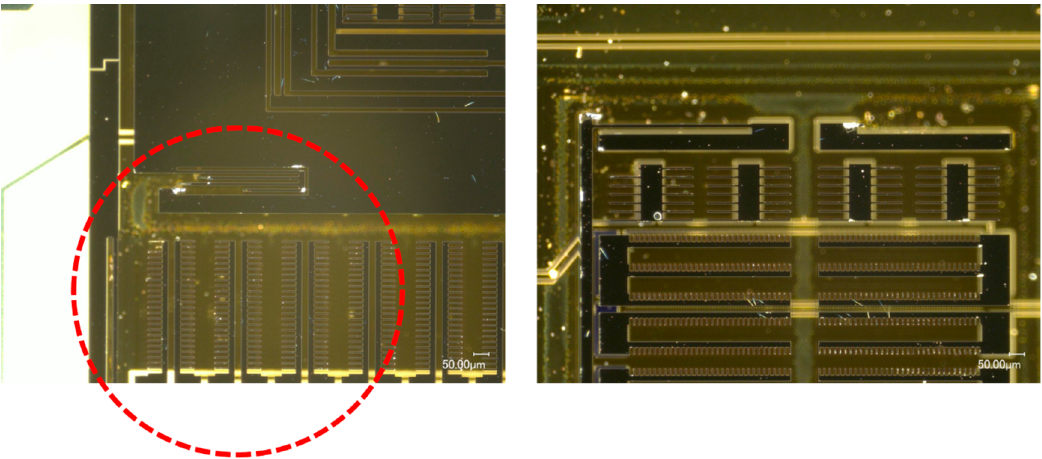
Figure 17. MEMS tuning fork gyroscope failures under negative Z-axis shock impact (a 0 = 20,000 g, τ = 80 µs).